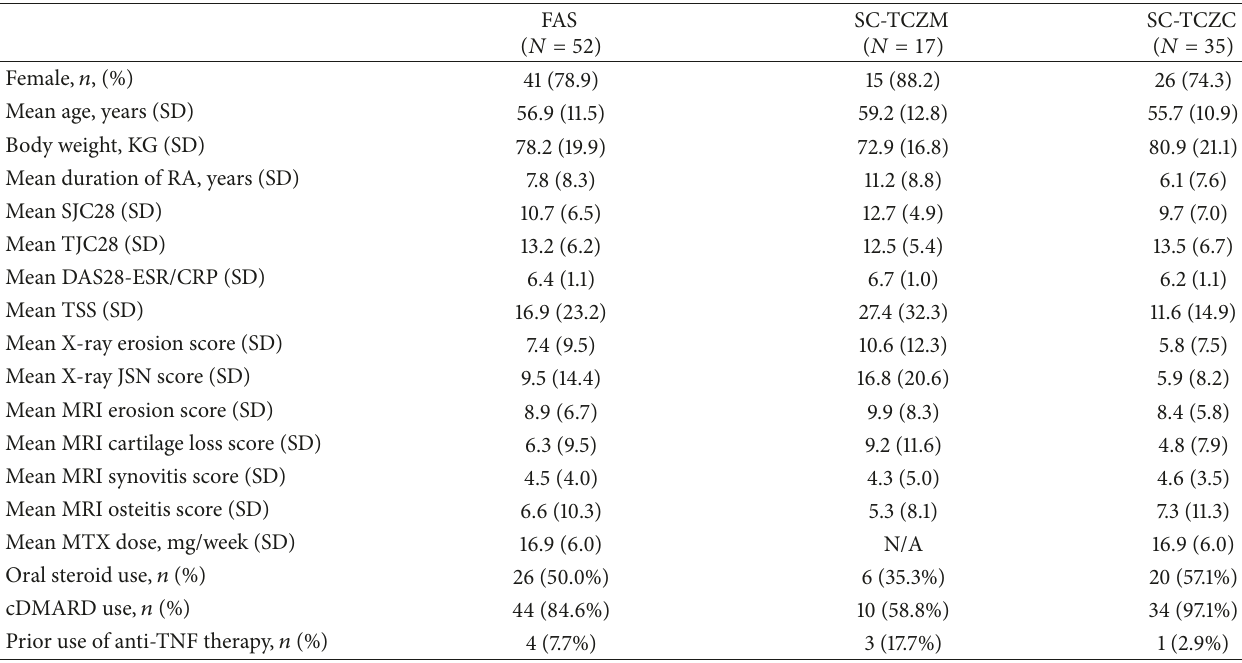
Table 1: Demographics and baseline characteristics.